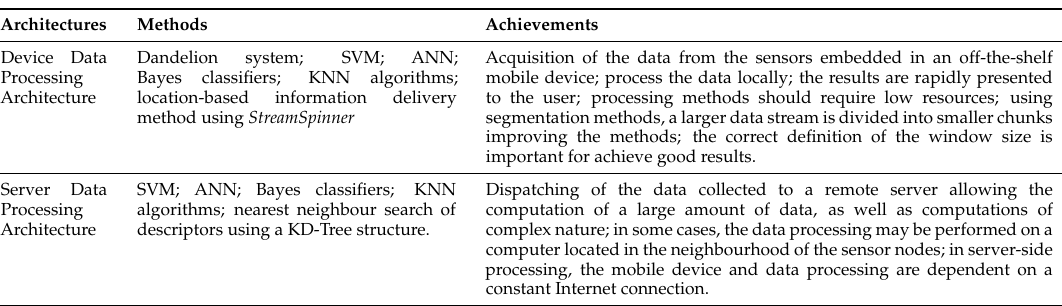
Table 3. Data processing: architectures and